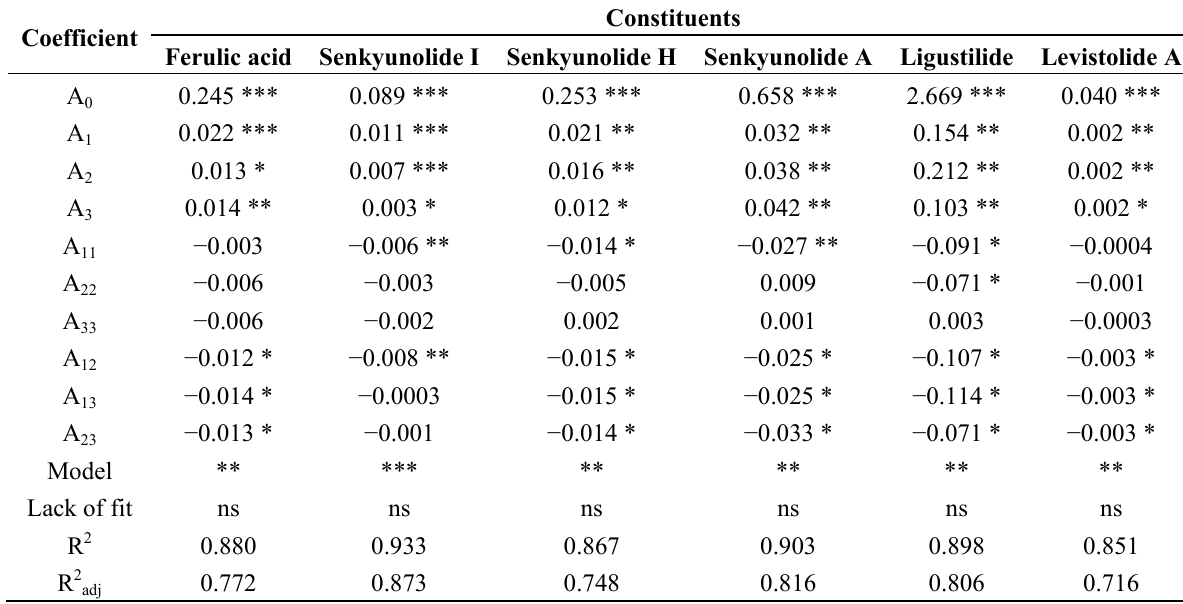
Table 3. Regression coefficients of predicted polynomial models for the investigated responses from L. chuanxiong